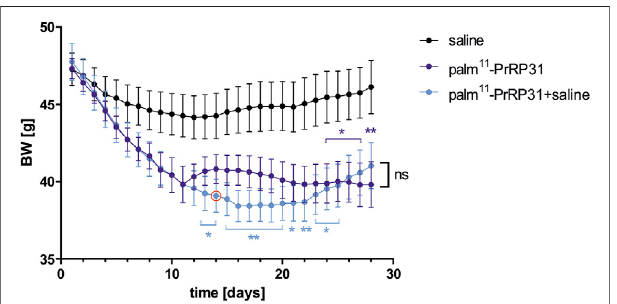
FIGURE1| Effectofchronictreatmentwithpalm 11 -PrRP31onBWinDIO mice. Mice were treated with palm 11 -PrRP31 for 4 weeks (palm 11 -PrRP31 group) or with palm 11 -PrRP31 for 2 weeks and for the following 2 weeks with saline(palm 11 -PrRP31+salinegroup),changeofthetreatmentmarkedby redcircle,modi fi edfrom(Holubováetal.,2018).Dataarepresentedasmeans ± S.E.M. Statistical analysis was performed by Two-way ANOVA with Tukey post hoc test, signi fi cance is p < 0.05, ** < 0.01 vs saline treated group. Body weight (BW) measured during the treatment, diet-induced obesity (DIO).